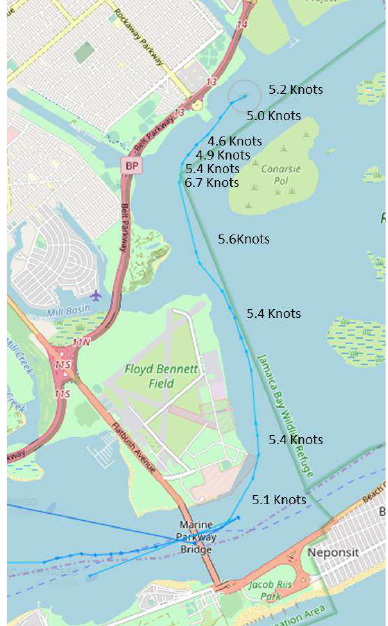
Figure A1. Rainbow Cruise (red circle) sailing to Rockaway Ferry Landing Point (blue star). Source [66].